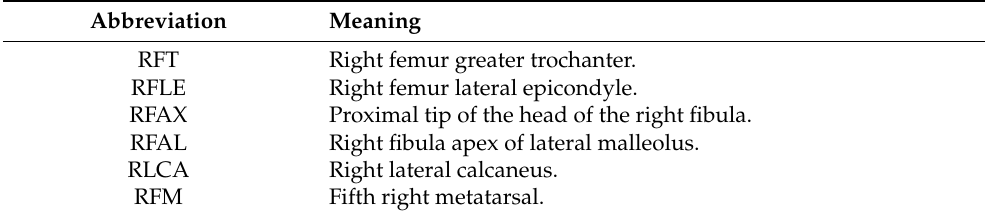
Table 1. Definition of the bone